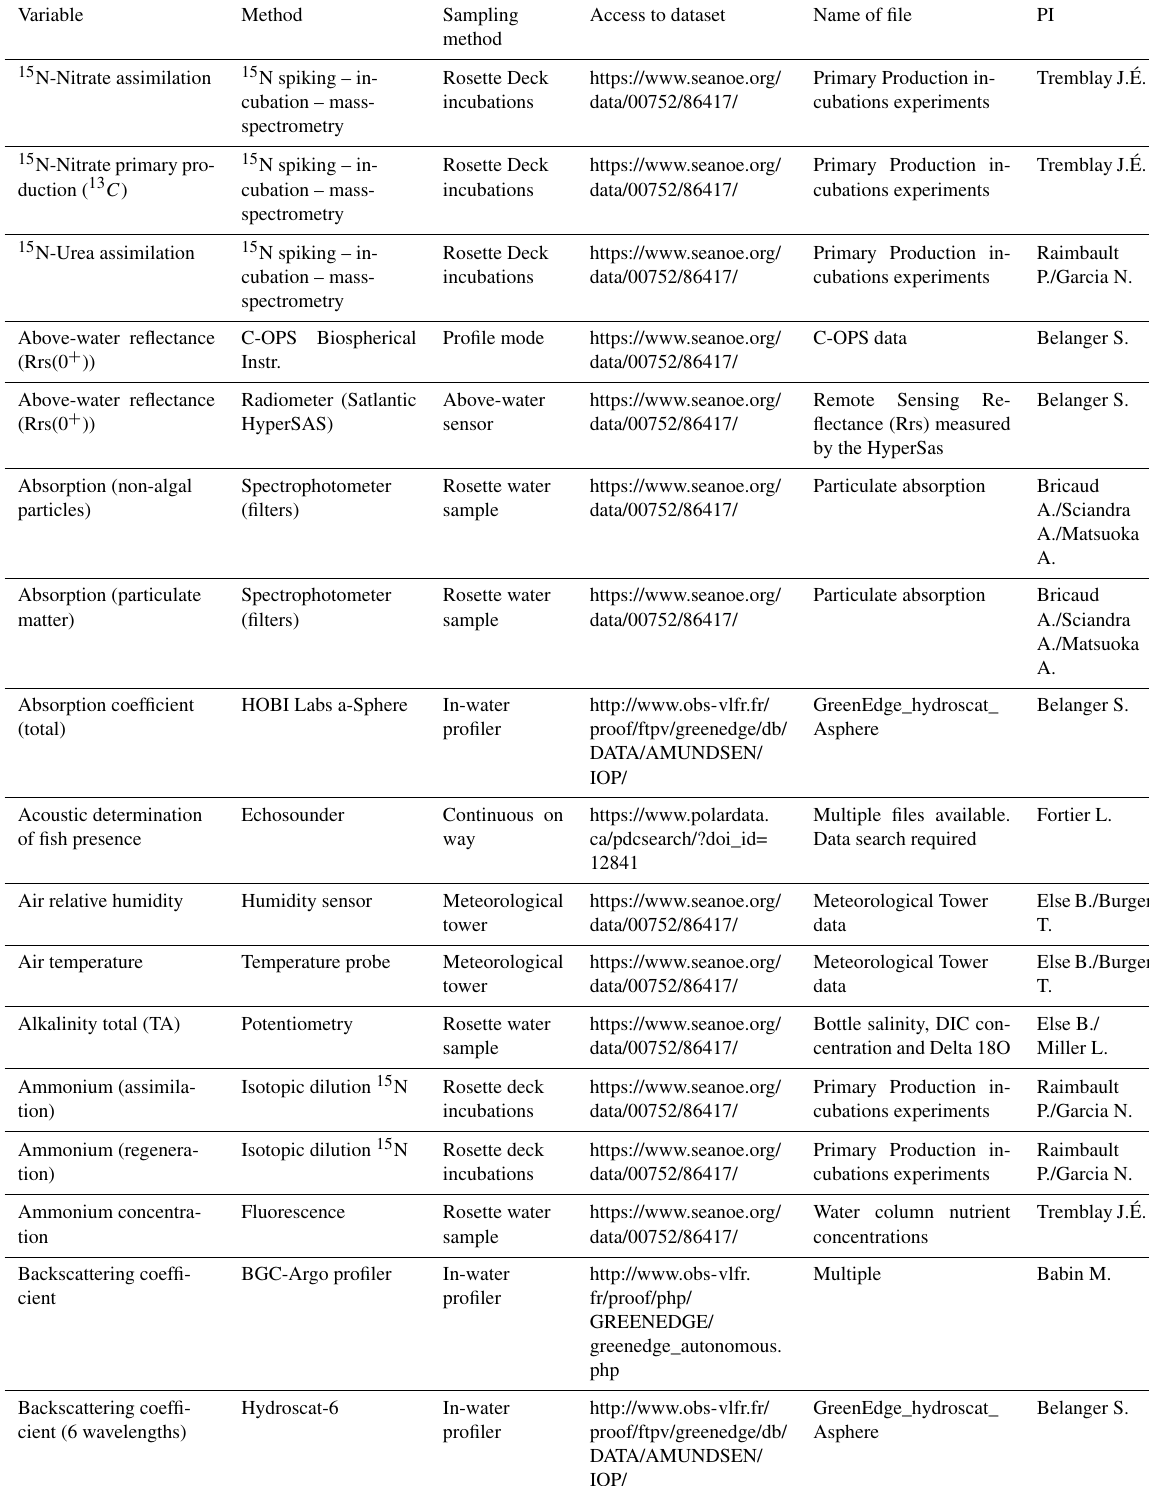
Table 3. List of all the variables sampled during the Green Edge cruise.